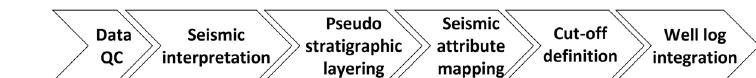
Fig. 7 Schematic visualization of the applied workflow used in this study